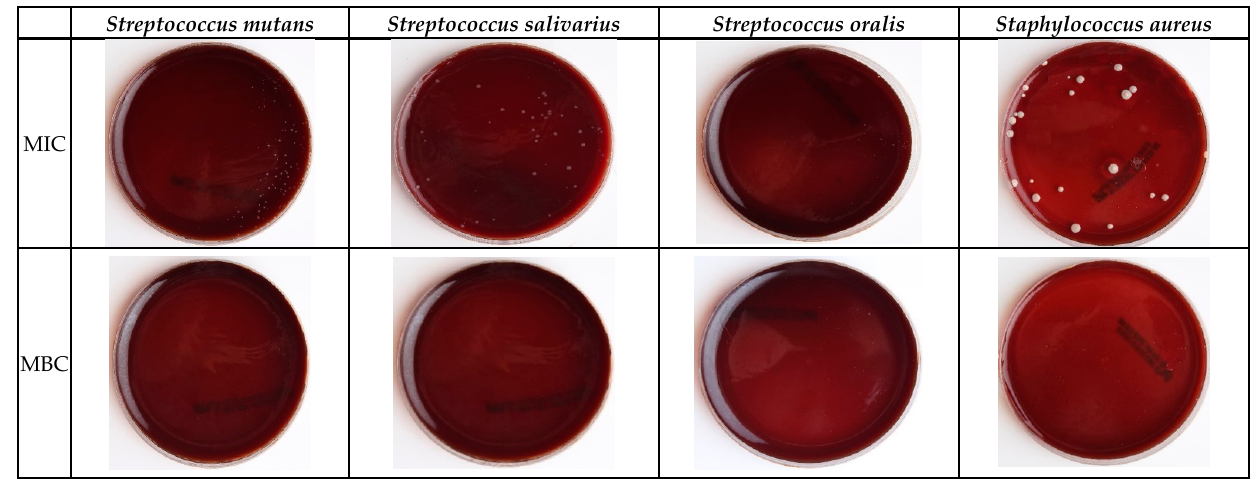
Figure 1. Bacterial growth; MIC (Minimal Inhibitory Concentrate) and MBC (Minimal Bactericidal Concentrate) of TQ with the four bacterial strains.